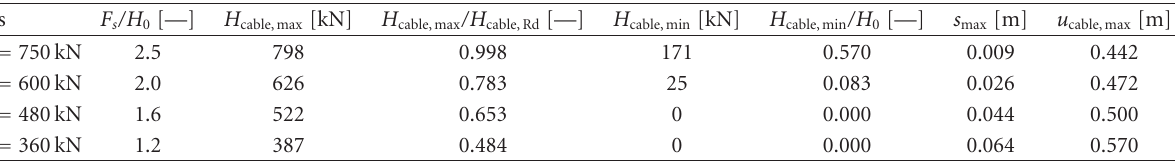
Table 4: Results of incremental analyses (ABAQUS, M02 FE-model, BL1). Fac¸ade with single vertical devices (V1). Cable axial forces, sliding of devices.